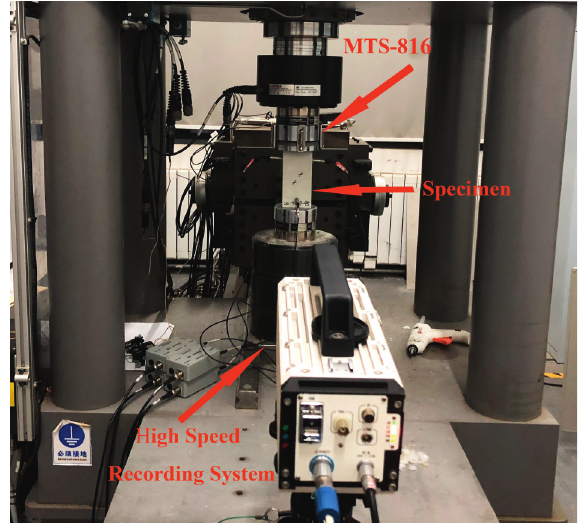
Figure 4: Loading devices and recording devices used for